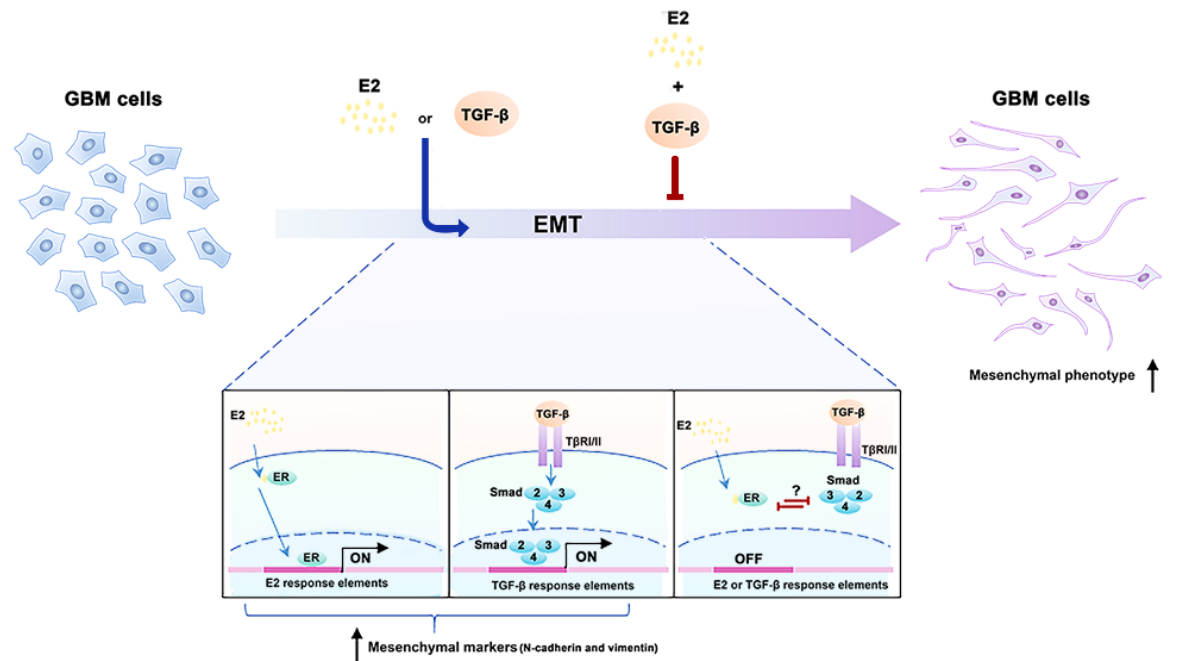
Figure 7. The molecular mechanism proposed for the activation or inhibition of EMT by E2 and TGF- β effects in human GBM cells. E2 and TGF- β promote EMT through ER and Smad, respectively. Crosstalk between ER and Smad inhibits EMT promoted independently by E2 and TGF- β . It is unknown whether the inhibition between E2 and TGF- β is through a direct or indirect interaction between ER and Smads. Epithelial–mesenchymal transition (EMT); 17 β -estradiol (E2), estrogen receptor (ER); glioblastoma (GBM); transforming growth factor β (TGF- β ); type I/II serine/threonine kinase receptor (T β RI/II).